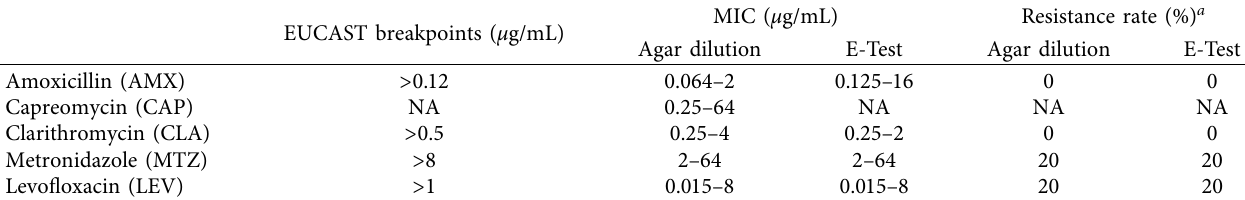
Table 1: Antimicrobial susceptibility testing of H. pylori by agar dilution and